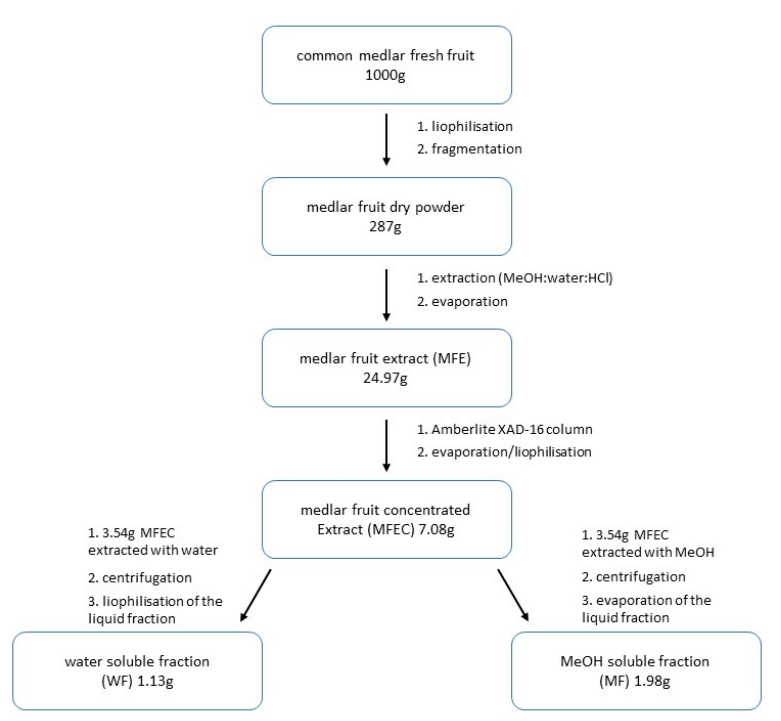
Figure 2. Extraction procedure to obtain concentrated methanolic (MF) and water (WF) fractions of medlar fruit extract (MFE). Table 2. The antioxidant activity: Trolox equivalent antioxidant capacity defined as the concentration of Trolox ( µ m) with the same activity as 1 g of the tested dry extract (ABTS and FRAP method). Material ABTS FRAP Fruit extract (MFE) 187.56 ± 15.76 b,c Fruit extract (MFE) Methanolic fraction